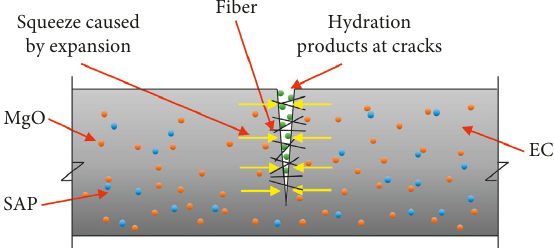
Figure 10: Typical load-displacement curves of shear test under different freeze-thaw cycles.